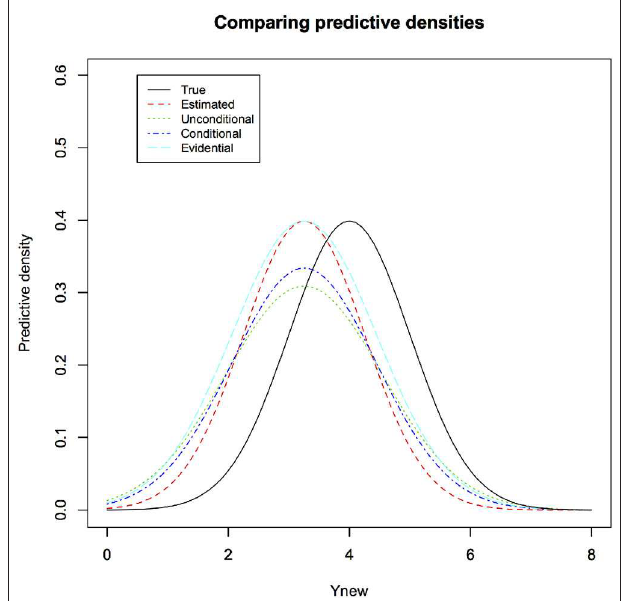
FIGURE 2 | The true density for the new observation under the linear regression through origin is different than the estimated predictive density based on the observed data. Classical conditional, Classical unconditional have slightly fatter tails than the estimated predictive densities. This leads to somewhat better coverage properties by accounting for the sampling variability. Evidential predictive density also has fatter tails than estimated predictive density. Its calculation, however, does not need sampling distribution and hence specification of the experiment to be repeated. It reflects the information in the observed data